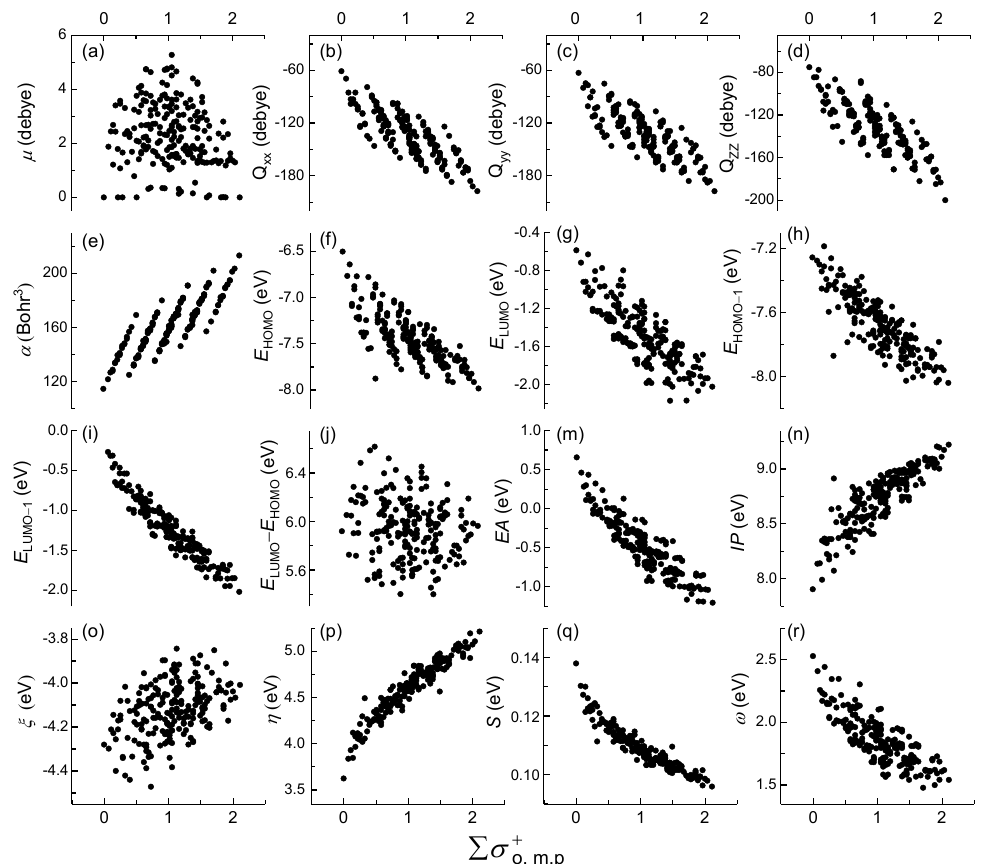
Figure 1. Relationships of 16 quantum chemical descriptors ( a – r ) and ∑ σ o, m, p+ for polychlorinated biphenyls (PCBs) congeners. The ( a ), ( b ) referred to our previous study [21].